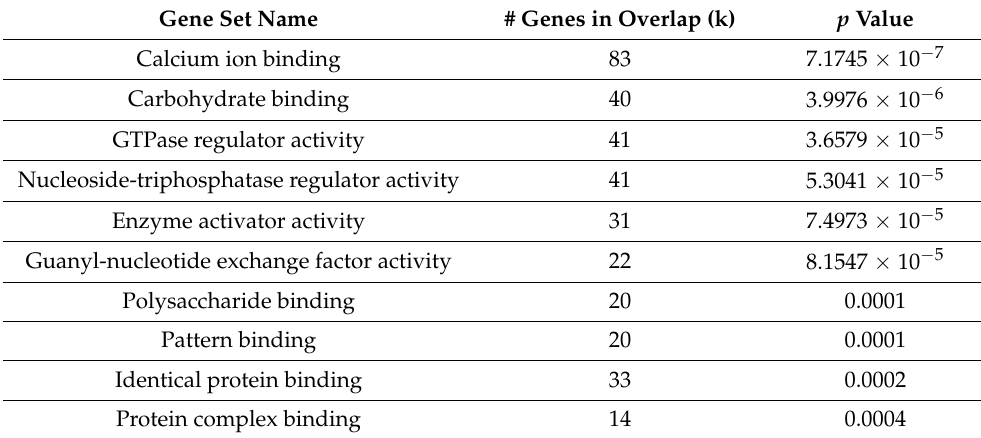
Table 2. Top ten molecular functions from Gene Ontology (GO) analysis.